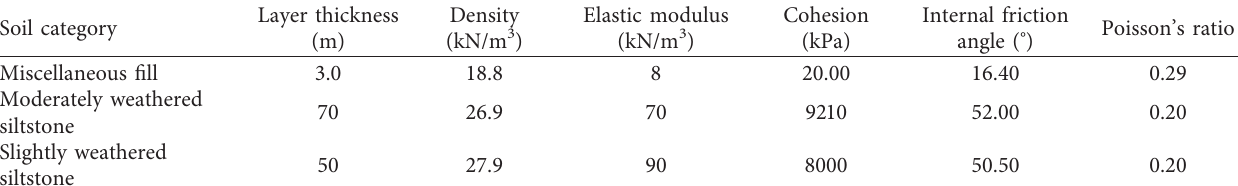
Table 1: Tunnel geotechnical properties.